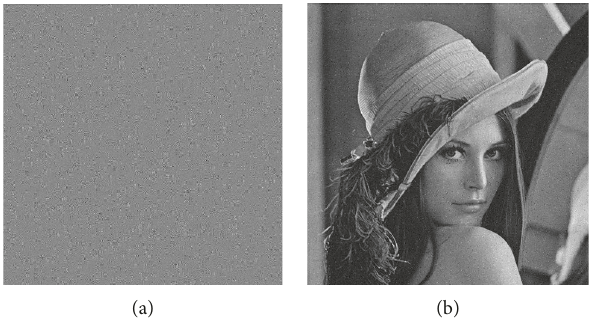
Figure 8: Effect of noise attacks with β � 5. (a) Encrypted image with noises. (b) Decrypted image.